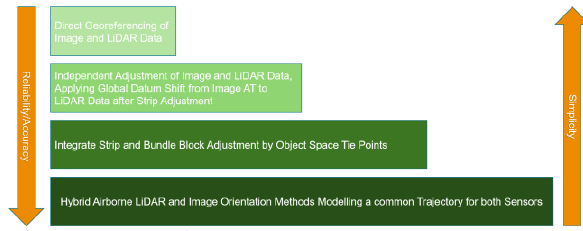
Figure 8: Levels of hybrid orientation